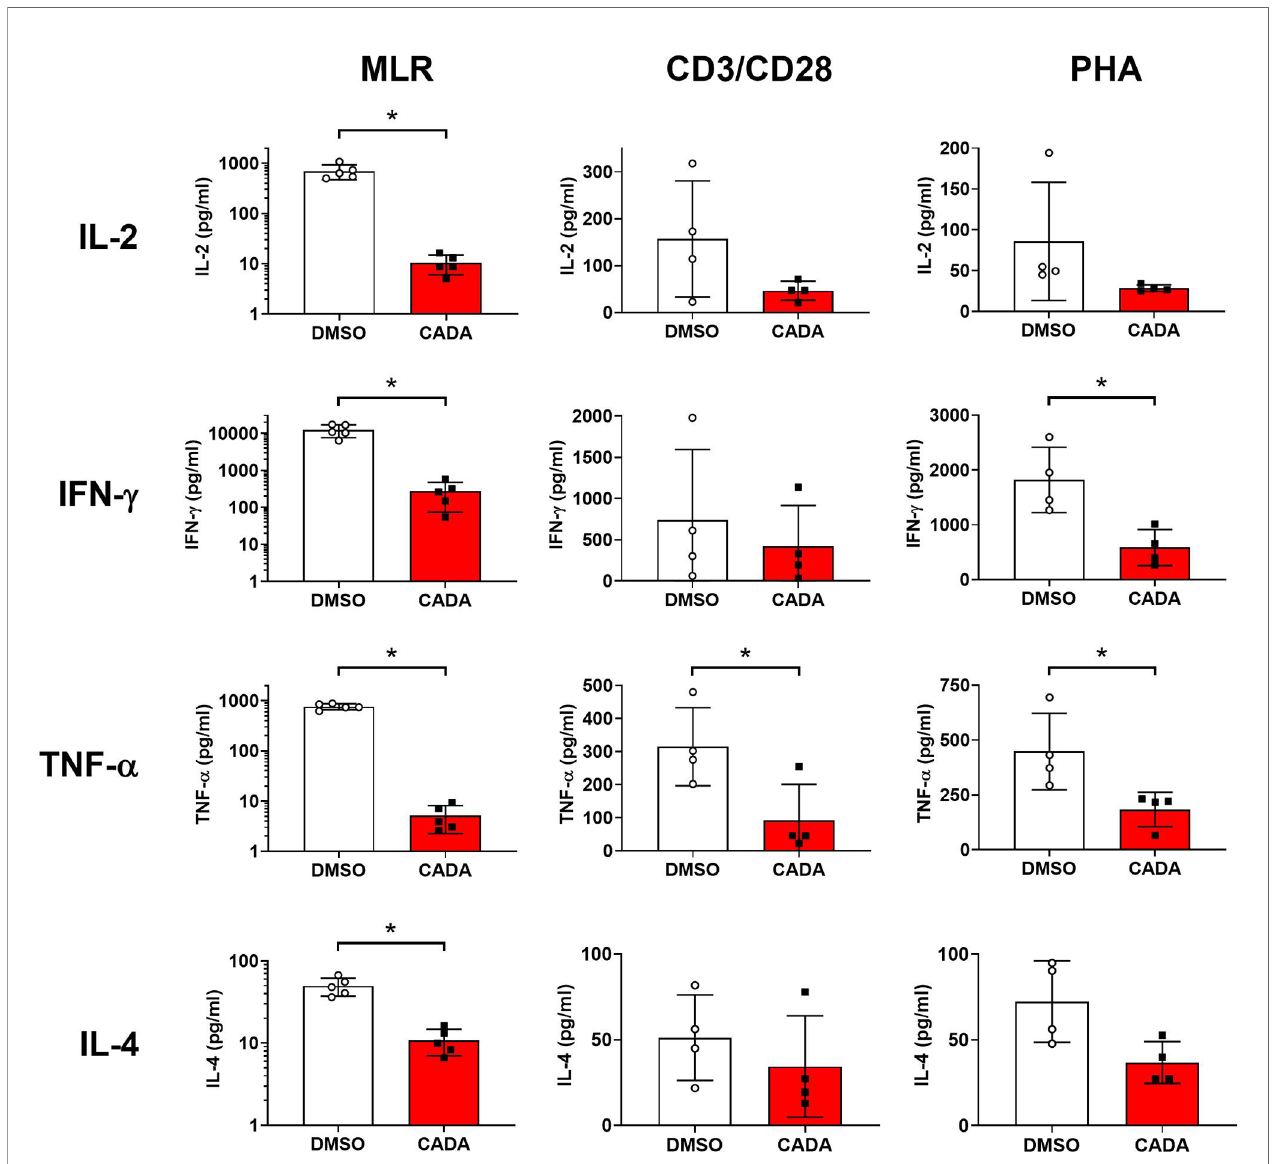
FIGURE 4 | CADA affects cytokine release by activated PBMCs. PBMCs were stimulated with mitomycin C inactivated RPMI1788 cells (MLR), CD3/CD28 beads or PHA and exposed to CADA (10 µM) as described in the legend to Figures 1 and 2 . Supernatants were collected on day 5 (MLR) or day 3 (beads and PHA) post stimulation and cytokine levels were determined by Bio-Plex assay. Bar diagrams are showing the cytokine concentration (mean ± SD), with DMSO in white and CADA in red, and with individual values shown as open (DMSO) or solid (CADA) symbols. Note that cytokine levels in the MLR samples are plotted on a logarithmic scale. Welch ’ s corrected t-tests were performed to compare CADA to DMSO with *p<0.05. Samples were taken from four (beads and PHA; n=4) or fi ve (MLR; n=5) different donors. See also Supplementary Figure 4